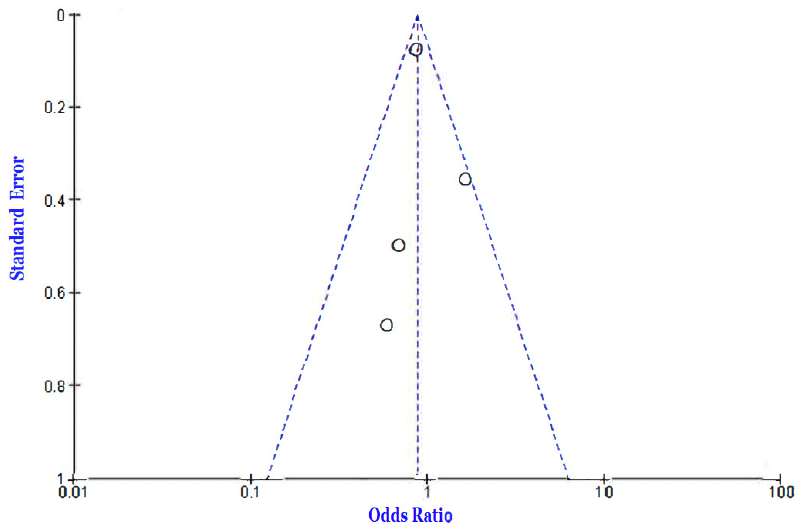
Figure 7. Funnel plot of the outcome of comparison in the well-controlled vs. poorly controlled gly- cemic comparison.